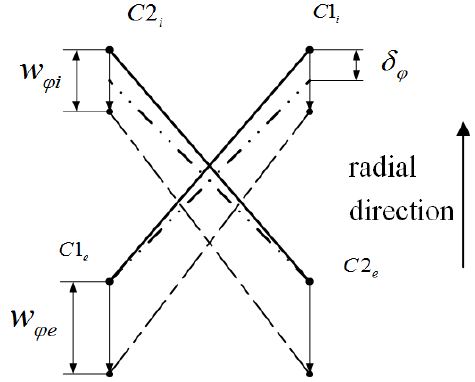
Figure 4: Position of groove curvature center considering